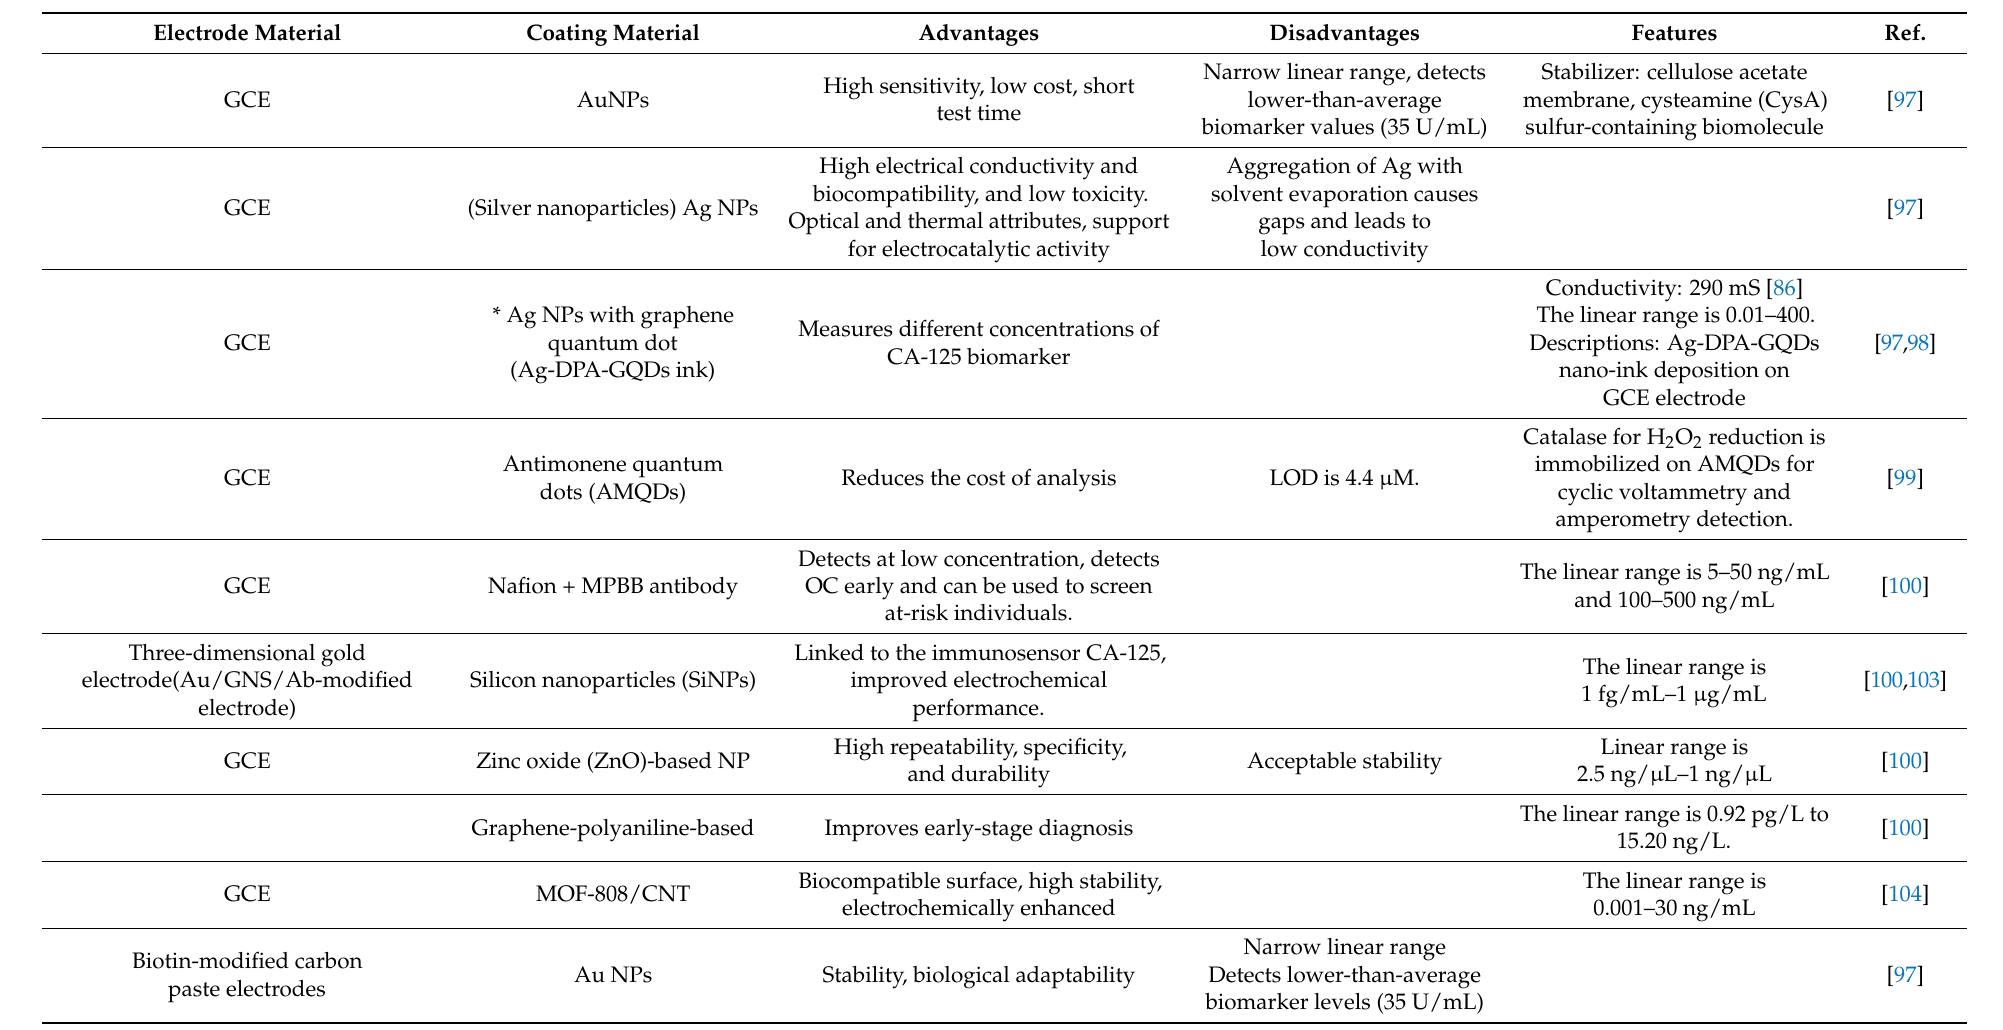
Table 2. Electrochemical biosensors for CA-125